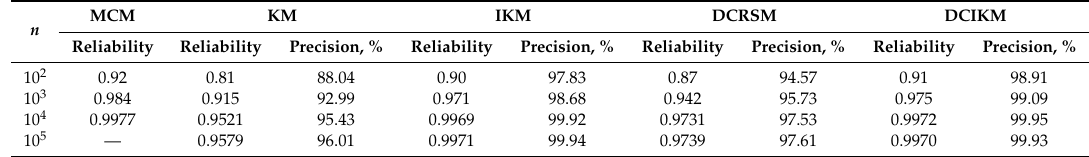
Table 5. Reliability analysis results of five methods for turbine rotor fatigue life ( N = 3296